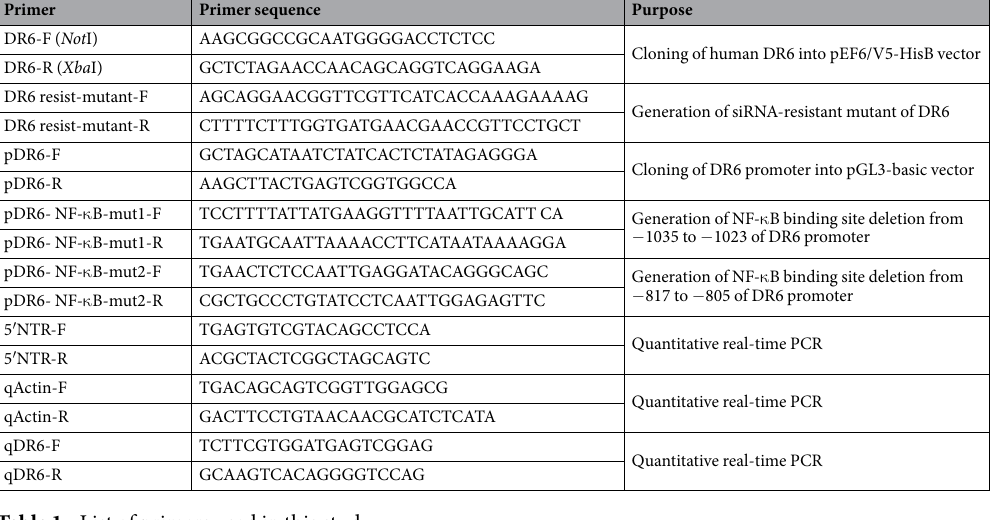
Table 1. List of primers used in this